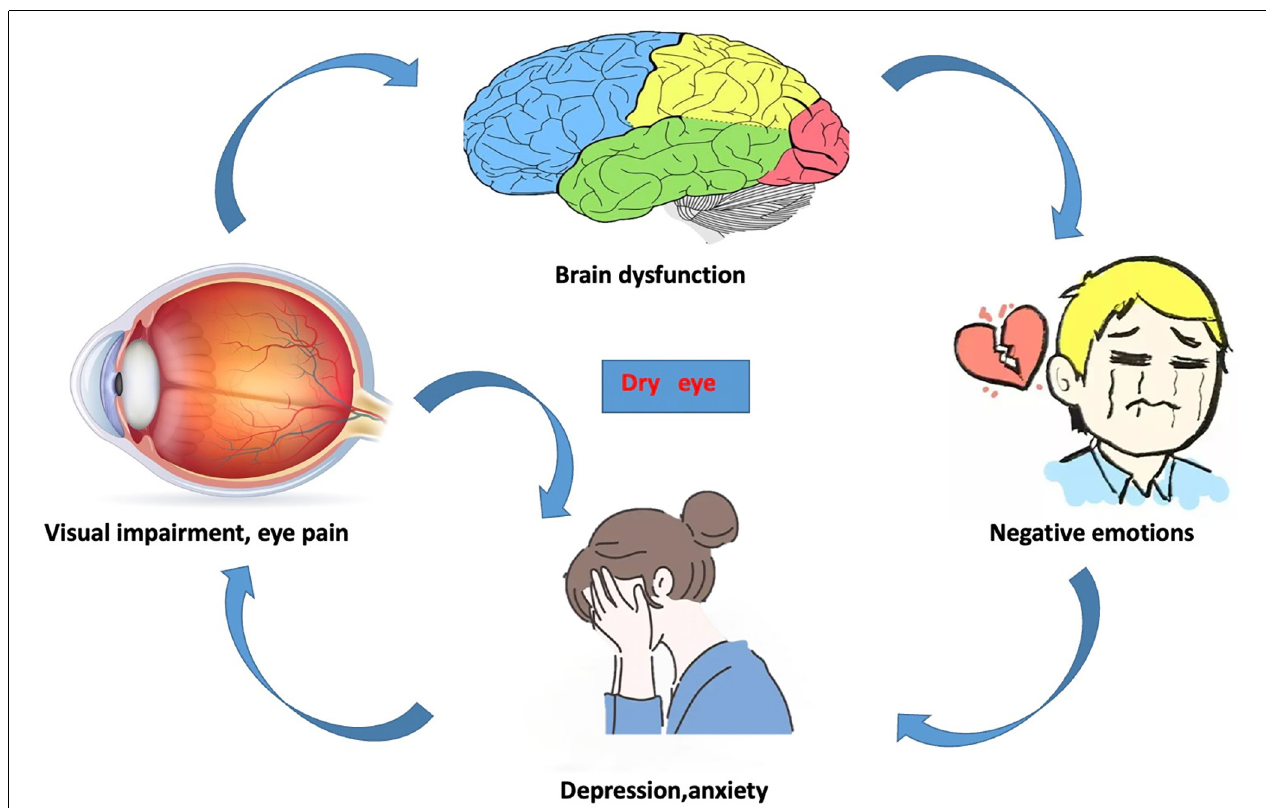
FIGURE 6 | The relationship between changes in internal eye states and vision, brain activity, and emotional state.